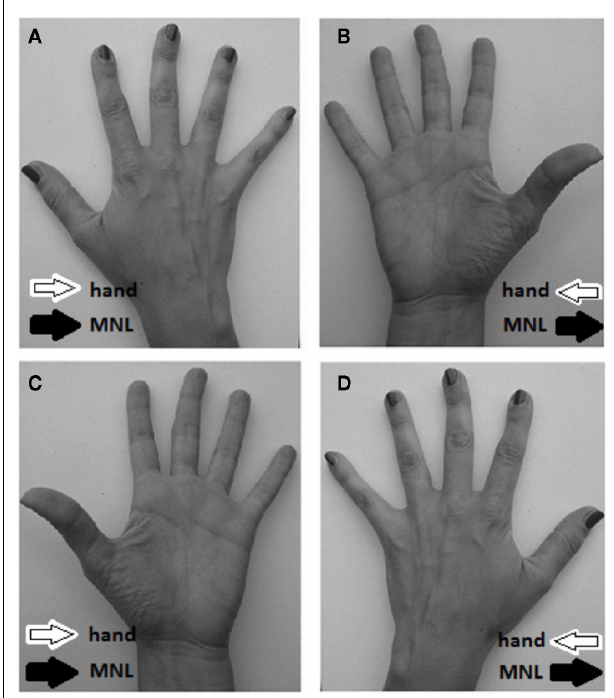
FIGURE 1 | Schematic showing the study main rationale. (A,B) Show a right hand in prone and supine posture respectively. (C,D) Show a left hand in prone and supine posture respectively. In (A,C) , within-hand counting direction (white arrow) is aligned with the mental number line direction (MNL, black arrow); in (B,D) , within-hand counting direction is misaligned with the direction of the mental number line.When unimanual responses are required with index and middle fingers, a regular SNARC effect should be present in condition (A,C) , whereas its presence in condition (B,D) may depend on the relative weight of the within-hand counting direction and the mental number line spatial